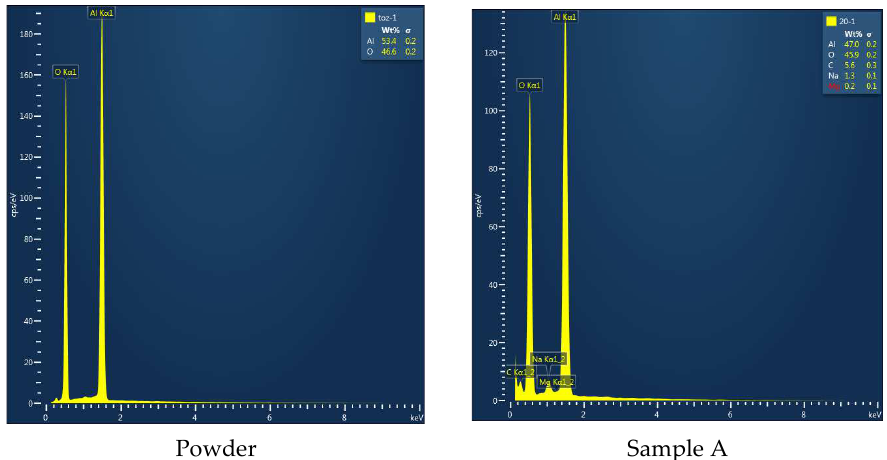
Figure 15. EDS of alumina powder and sample A printed using the developed preheating system.